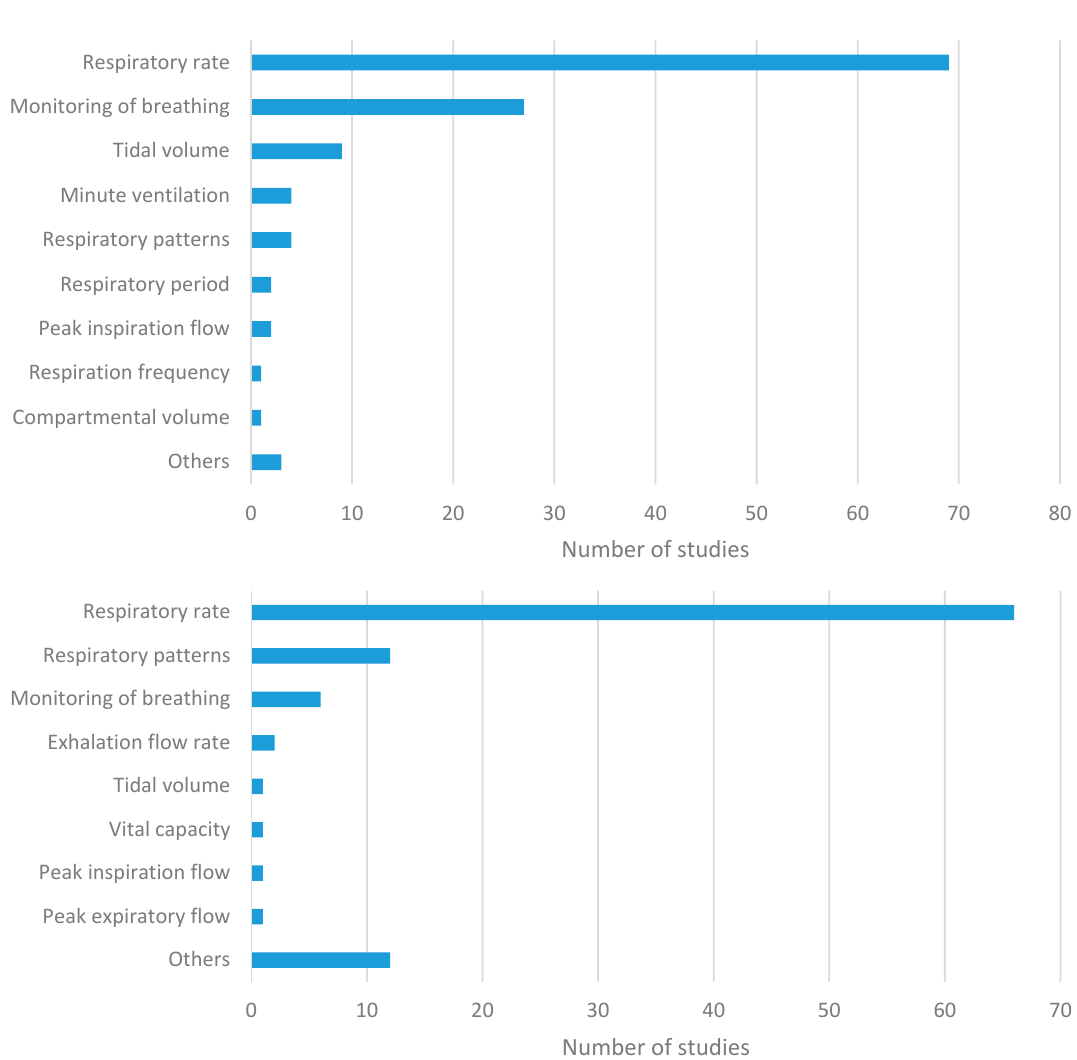
Figure 8. Number of studies obtaining the di ff erent respiratory parameters for the wearable ( top ) and environmental ( bottom ) categories.